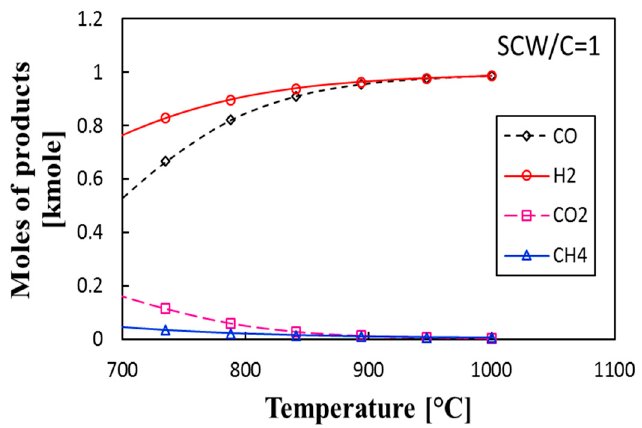
Figure 5. Variation of the mole fraction of the productions with temperature of the reactor R 1 at reference conditions given in table 2.